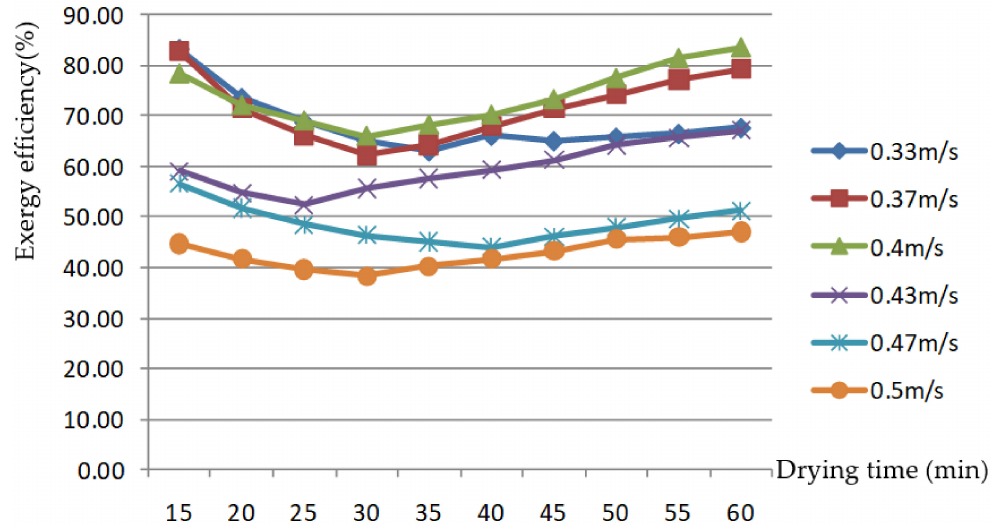
Figure 8. Exergy efficiency changes with drying time at different air